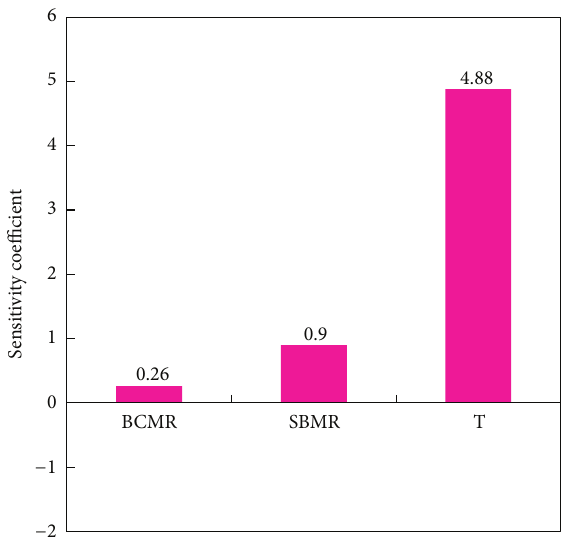
Figure 5: Relative linear sensitivity coefficients of H 2 production efficiency towards the operation